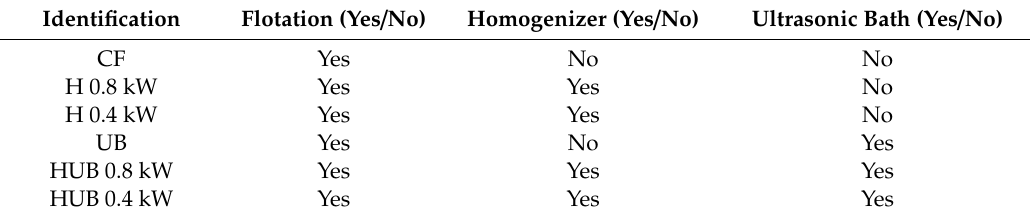
Table 3. Description of various experimental configurations applied during simultaneous flotation tests with the ultrasonic